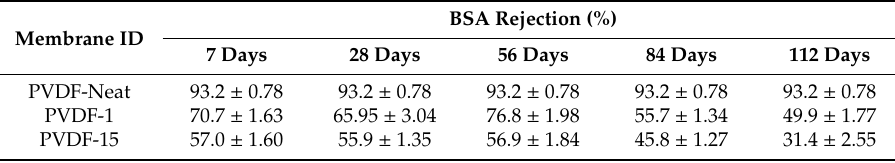
Table 2. Rejection study of neat and embedded PVDF